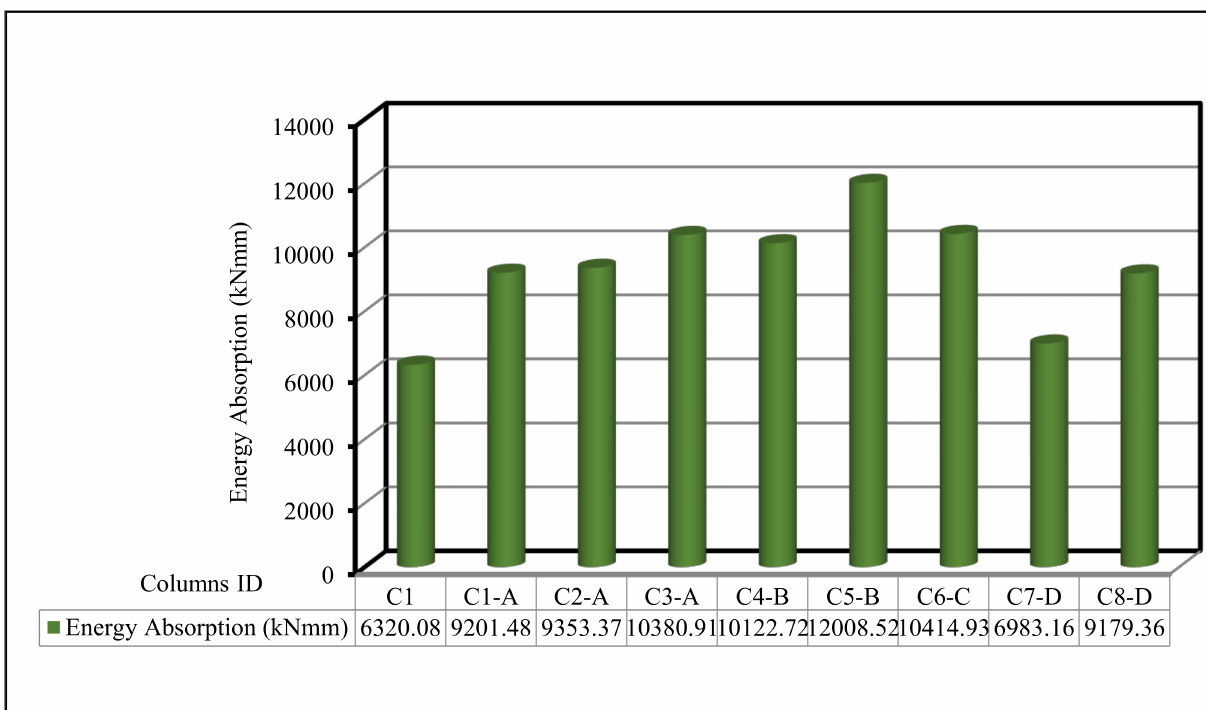
Figure 14. Energy absorption for the tested